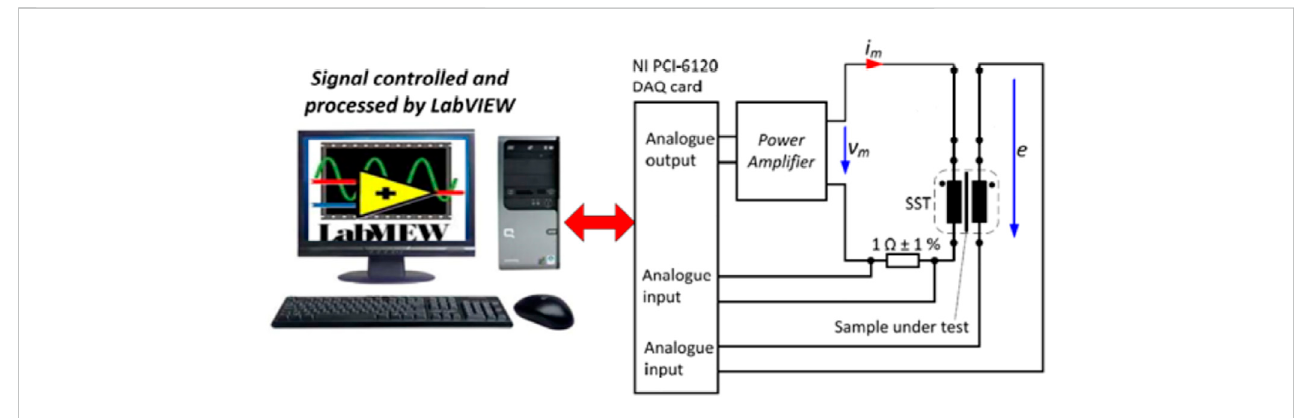
FIGURE 2 AC magnetic property measurement